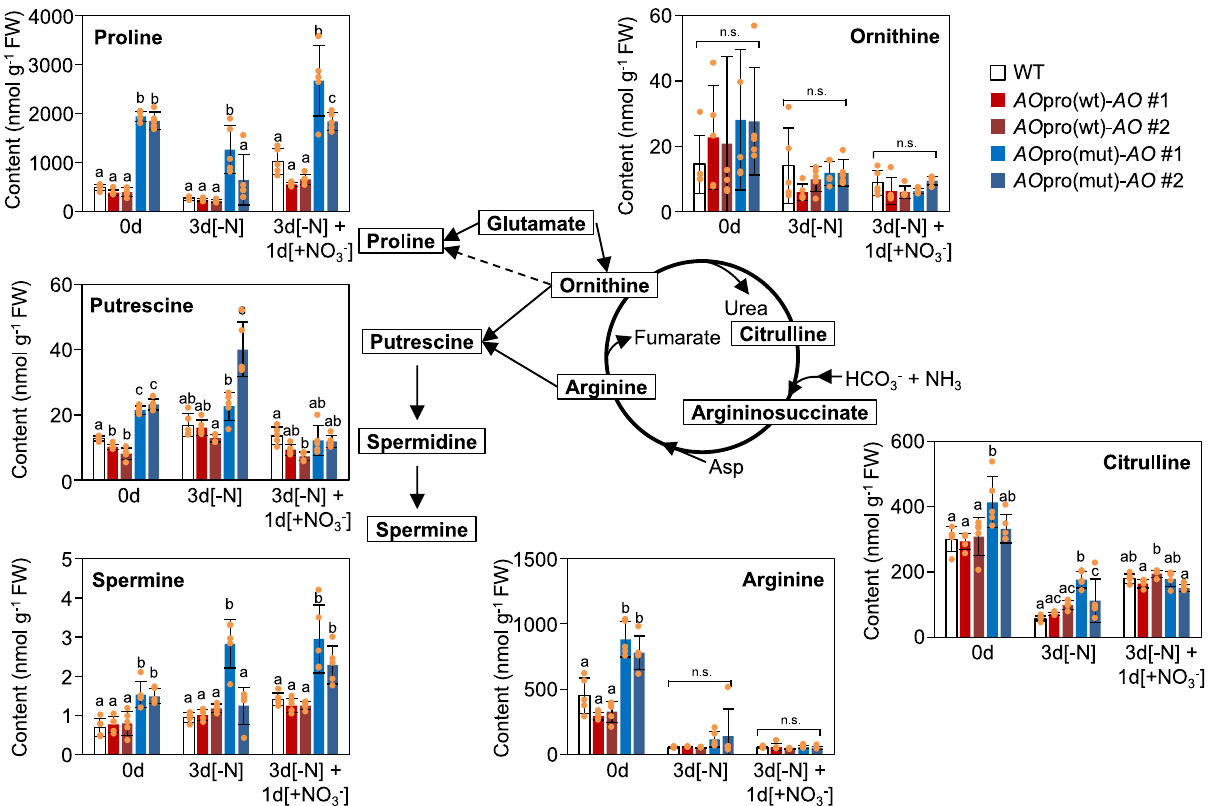
Fig. 7 Abnormal accumulation of urea cycle-associated metabolites in AO pro(mut)- AO plants. Contents of urea cycle-associated metabolites were measured in the shoots of WT, AO pro(wt)- AO , and Ao pro(mut)- AO plants grown according to the scheme shown in Fig. 5a. Two independent lines (#1 and #2) of AO pro(wt)- AO and AO pro(mut)- AO plants were used. Data represent mean ± SD ( n = 5). Different letters denote statistically signi fi cant differences (Tukey ’ s HSD test; P < 0.05).